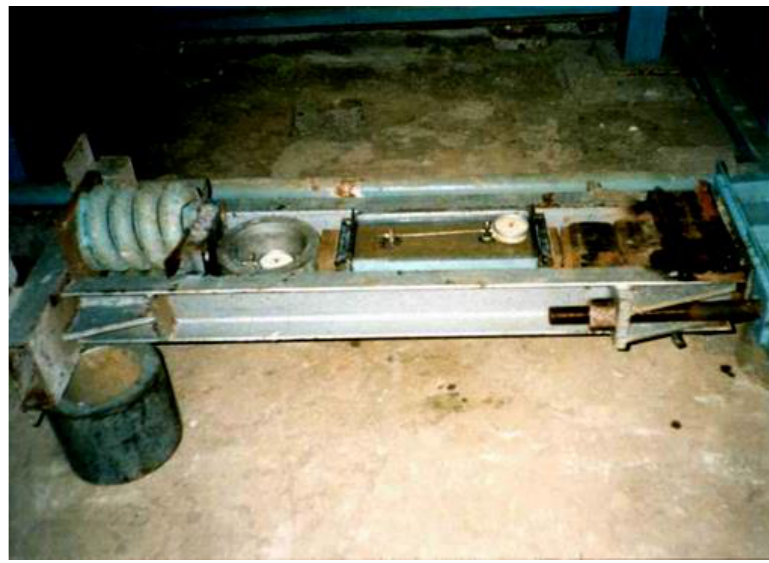
Figure 5. The power stand for experimental testing of prisms in aggressive medium. The following symbols were used for the marking of prisms: P—prism, and L—tested for long-term loading (see Table 3). The marking included two numbers, the first of which indicates the series of prisms (1, 2, 3, 4), and the second indicates the sequence number of the sample in this series (1, 2, 3, 4, 5). The letter “c” shows that the prism was subjected to aggressive impact